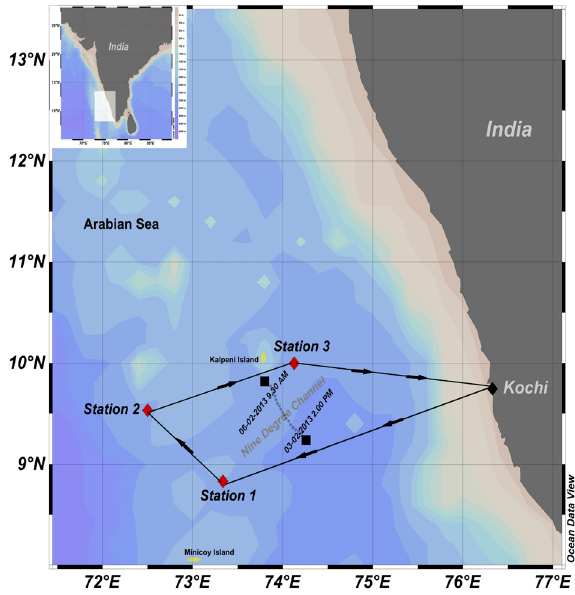
Image 1. The cruise track and location of Pilot Whale sighting in Arabian Sea. Red mark indicates fishing stations and black mark indicates whale sighting. Dotted line indicates possible track of whale movement. Image 2. The Short-finned Pilot Whale top